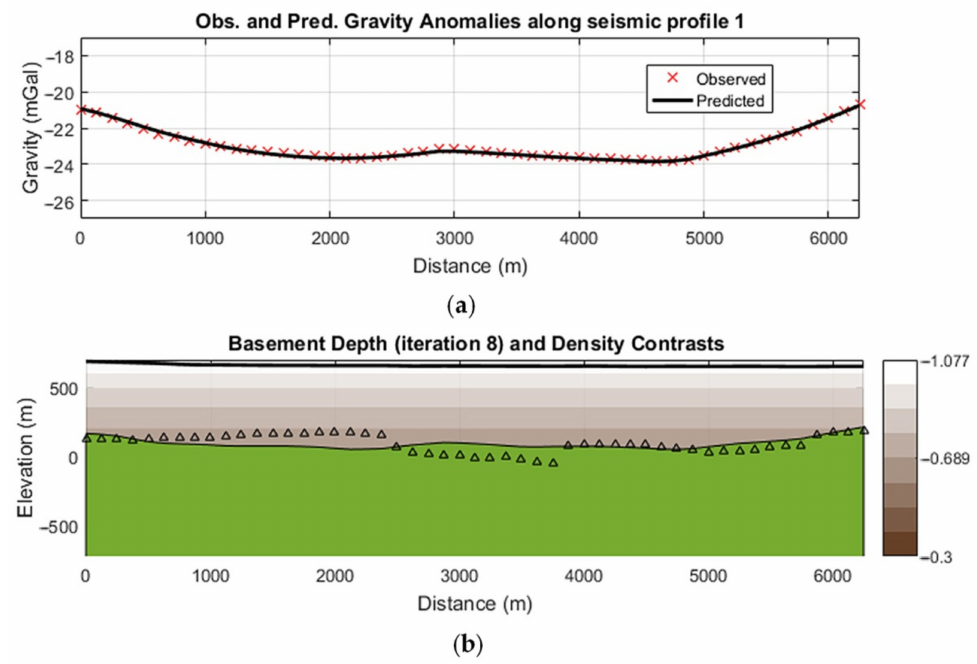
Figure 9. Comparison of the depth to the seismic reflector interpreted as the top of the carbonatic rocks, and the gravity basement along the seismic profile 1 (see Figure 2). ( a ) Observed and model- predicted gravity; ( b ) gravity basement (green) and seismic reflector (triangles). Brown shading represents the density contrast variation with depth estimated in the ITRESC